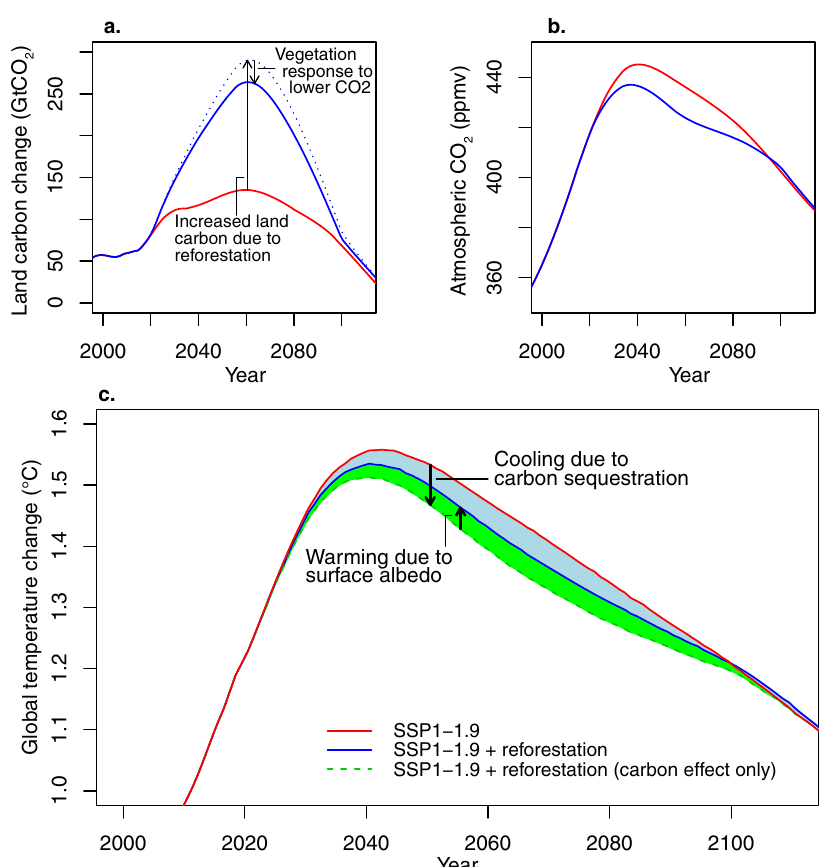
Fig. 2 Climate response to a temporary reforestation-driven carbon removal scenario. a Reforestation to the year 1920 forest extent led to an additional 129 GtCO 2 of land carbon storage relative to the baseline SSP1-1.9 scenario, which was subsequently returned to the atmosphere during the second half of this century. b Atmospheric CO 2 concentrations decreased by 12.3 ppm in response to this increase in land carbon storage. c Peak temperature in this scenario decreased by 0.022 °C, with the maximum temperature decrease relative to baseline scenario reaching 0.045 °C around the year 2060. The primary biophysical effect of expanded global forest cover was to decrease land surface albedo, which consequently decreased the climate response to reforestation by about 45% relative to the temperature change that would have occurred in response to only carbon were 0.022 °C lower than in the baseline simulation (Fig. 2c). This represents a global temperature response to the removal of 0.3 °C per 1000 GtCO 2 of removal. Compared to the idealized case in Fig. 1 (0.5 to 0.55 °C per 1000 GtCO 2 of removal), this means that a unit removal of carbon via global reforestation in our model is about 45% less effective at decreasing global temperatures as compared to NbCS strategies that do not affect land surface albedo. Indeed, when we removed the biophysical effects from the reforestation simulation (dashed green line in Fig. 2c; see Methods) the maximum temperature difference was 0.08 °C (with a peak temperature decrease of 0.045 °C) representing equivalent global temperature effectiveness of removal as in the idealized removal simulations. This result emphasizes the potentially signi fi cant non-CO 2 biophysical effects of NbCS implementation; our model does not represent all such potential effects, however, most notably that of changing cloud cover in response to forest distribution changes which has been shown to cause a local cooling effect in response to increased forest cover 26,30 . It is likely therefore that including a more complete representation of non-carbon effects would cause temperature changes in this scenario to fall somewhere within the green shaded region of Fig. 2c, rather than following either the blue or green lines. varied